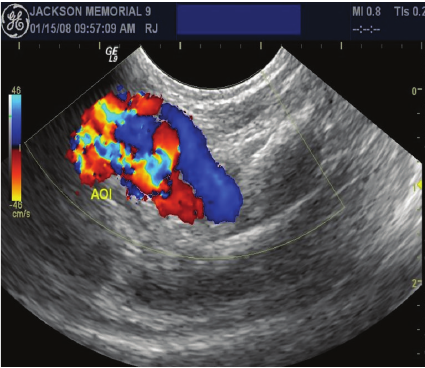
Figure 1: The distal left brachial artery to brachial vein fistula.